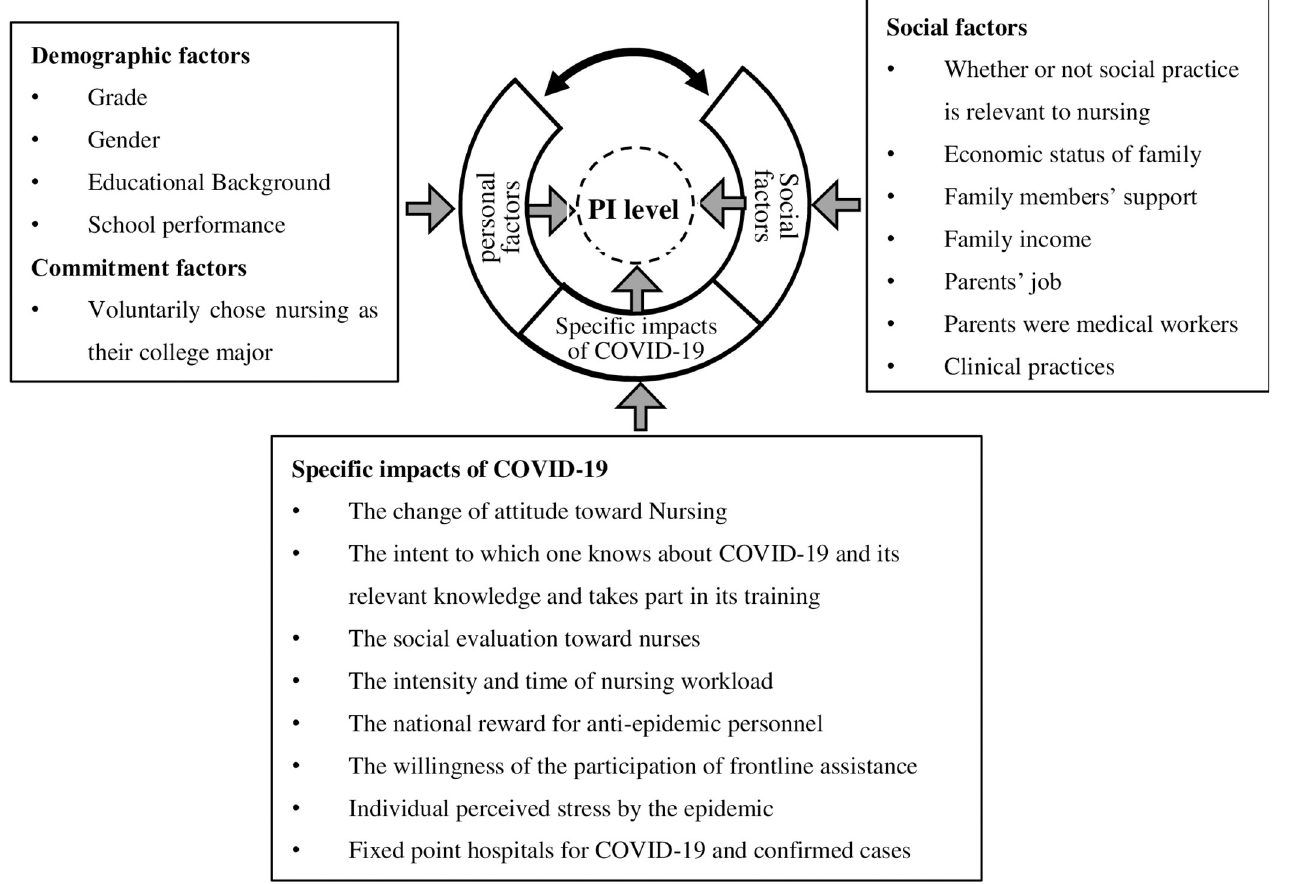
Fig 2. Factors effecting the PI of intern